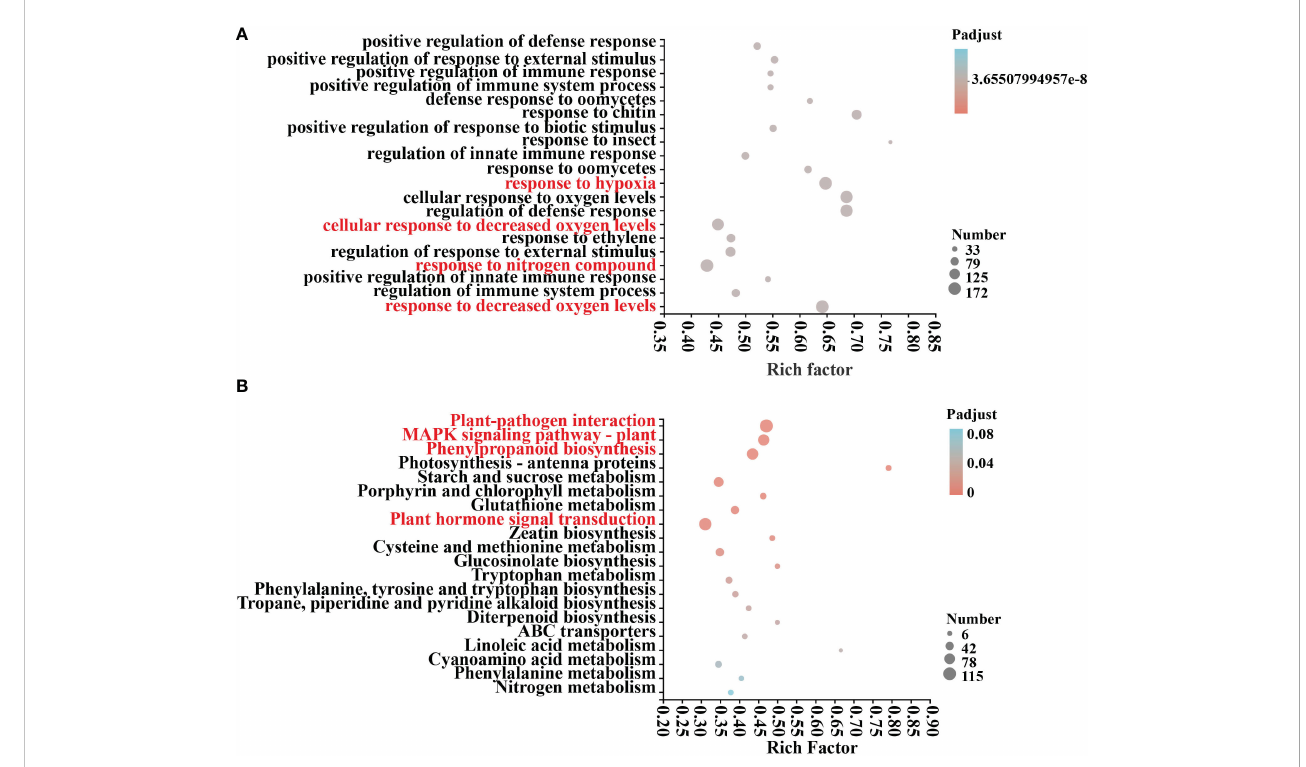
FIGURE 3 GO and KEGG differential gene enrichment analysis. (A) GO enrichment analysis of DEGs. (B) KEGG enrichment analysis of